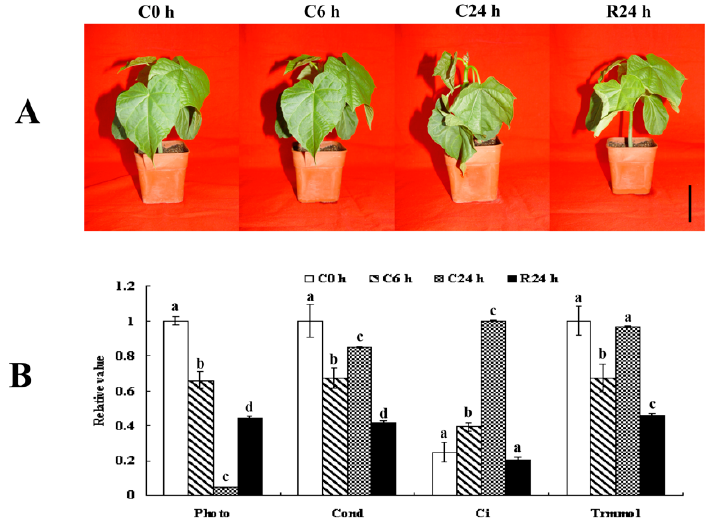
Figure 1. Morphological and physiological responses of J. curcas seedling to different treatment condition. Four-leaf stage seedling were treated at 4 °C for 0, 6 and 24 h (C0 h, C6 h and C24 h) and then allowed to recover for 24 h (R24 h) ( A ). The black bar equals 6 cm. The Pn, Cond, Ci and Trmmol were showed in ( B ). The values of relative % for each column are means ± S.D. of three biological replicates. The different lowercase letters labeled above columns indicate significant changes according to one-way ANOVA ( p < 0.05).